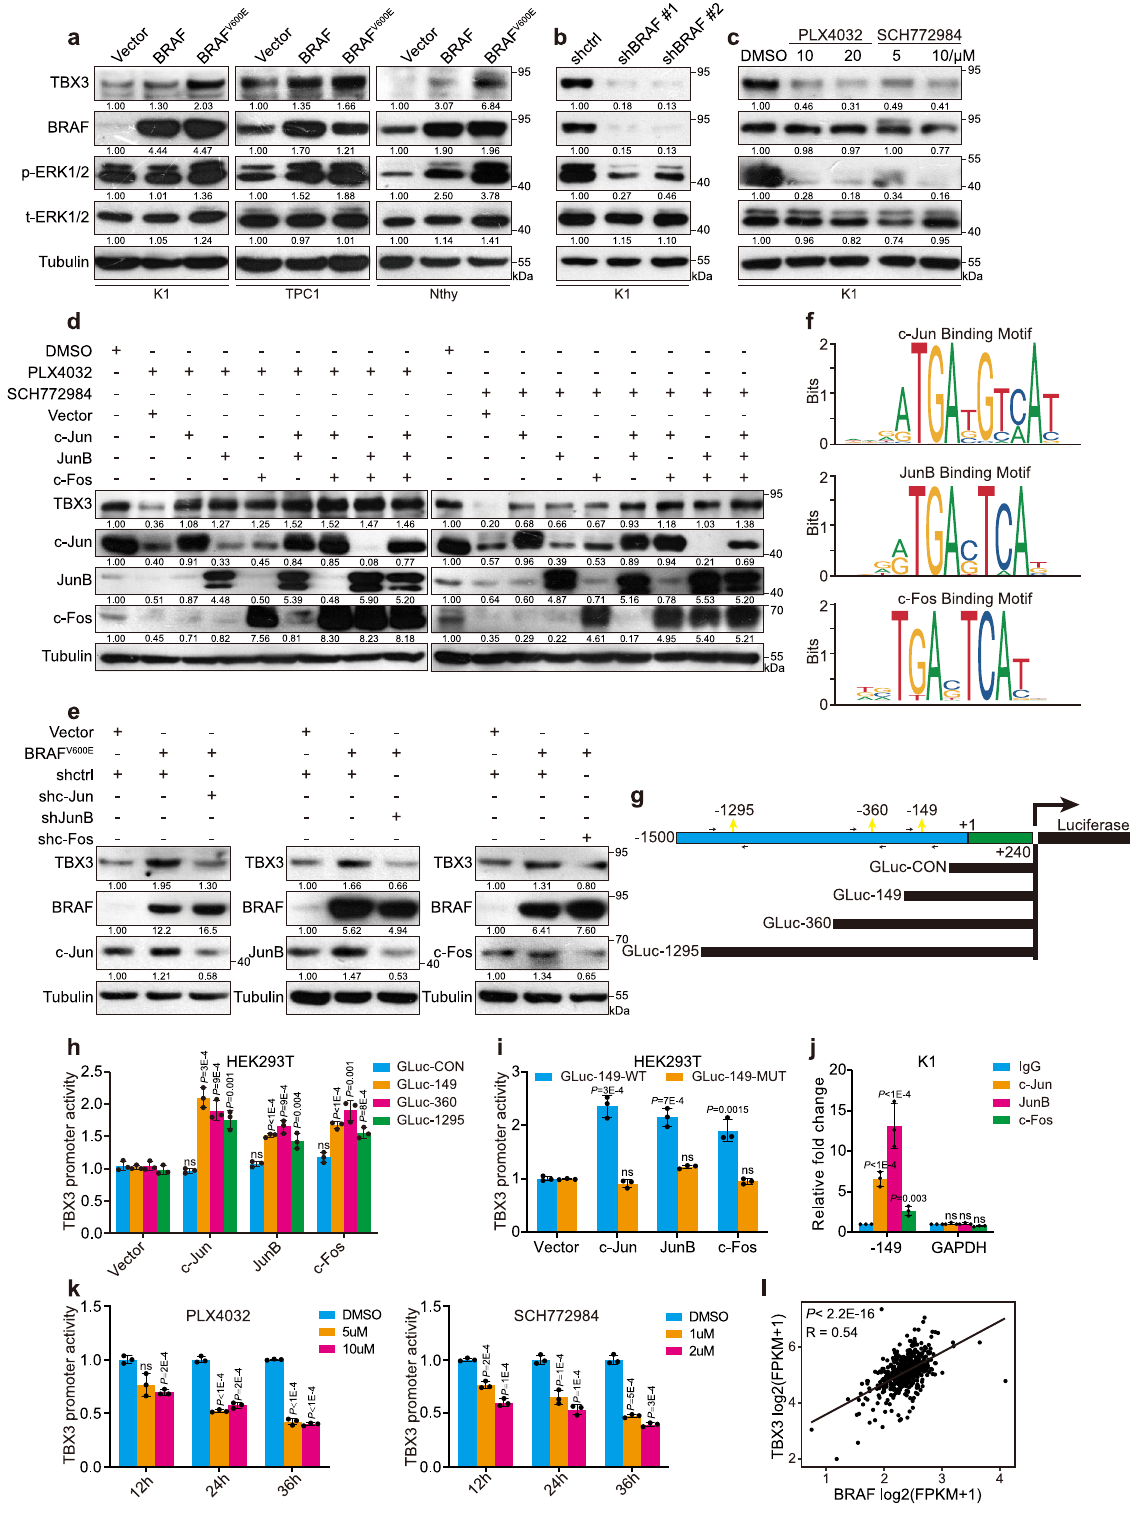
Fig. 3b and Supplementary Data 1). During validation of repre- sentative genes by RT-qPCR, we con fi rmed de-repression of proliferation restricting genes including Cdkn1c, Cdkn2c, and Klf9 upon Tbx3 knock-out, and repression of oncogenic genes such as Igfbp3, Mmp9, Met and Six4 (Fig. 3c). More interestingly, expression of CXCL chemokine members including CXCL1, 2, 3